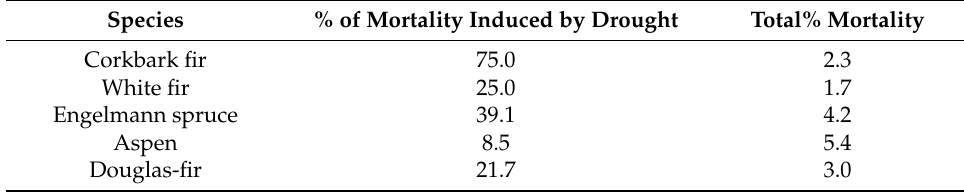
Table 5. Direct measurement of drought-induced mortality for all Spruce-fir species in 2005.